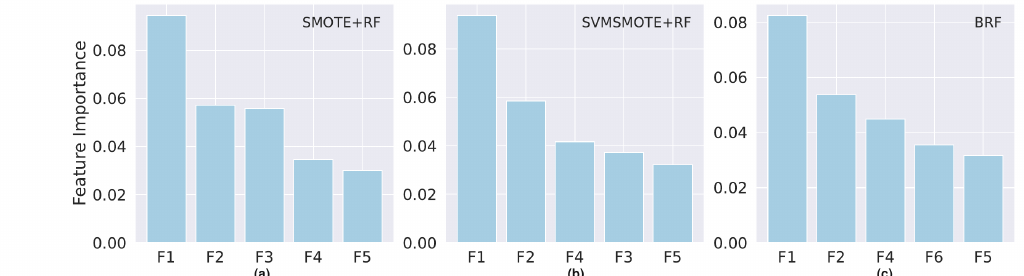
Figure 7. Top five most important features for models built with dataset S1 for the models with